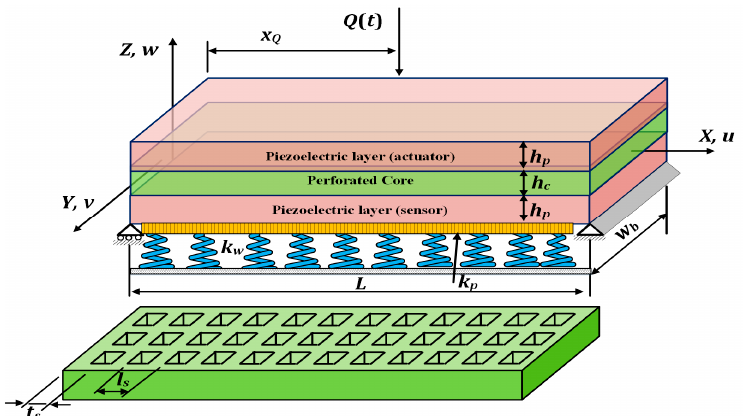
Figure 1. Geometry of piezoelectrically layered perforated nanobeam embedded in an elastic foun- dation.